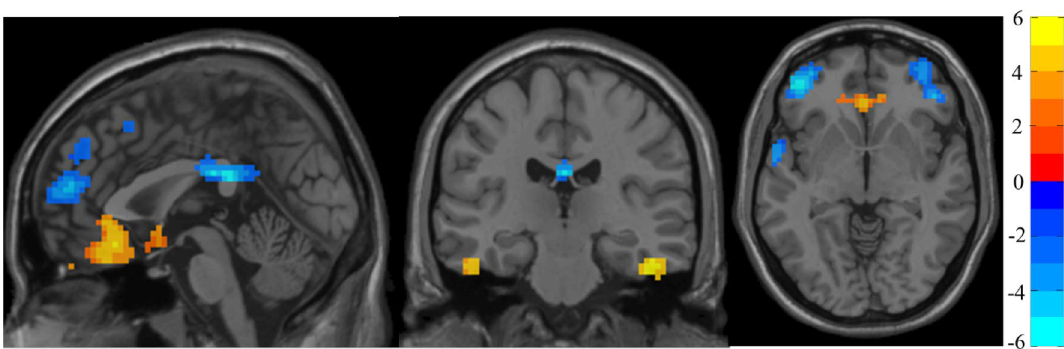
Figure 2. ReHo analysis. Two-sample t test results corrected by TFCE are presented. The area in blue represents a significantly decreased ReHo value in DS patients compared with controls; the area in yellow and red represents a significantly increased ReHo value in DS patients compared with